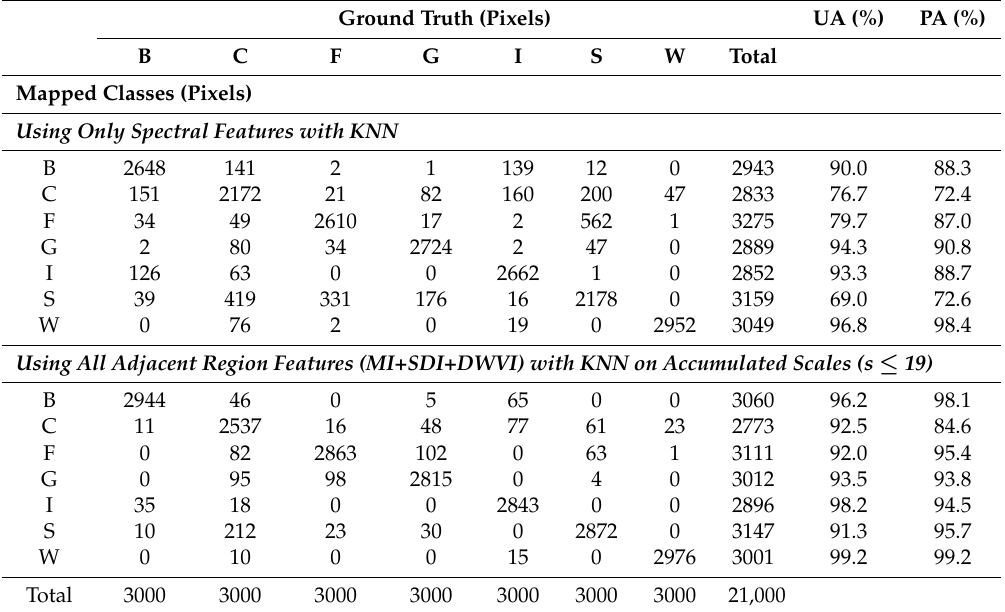
Table 2. Confusion matrixes of LULC Classification using K nearest neighbor (KNN) classifiers with only spectral information and the configuration that achieved the highest overall accuracy (94.52%).